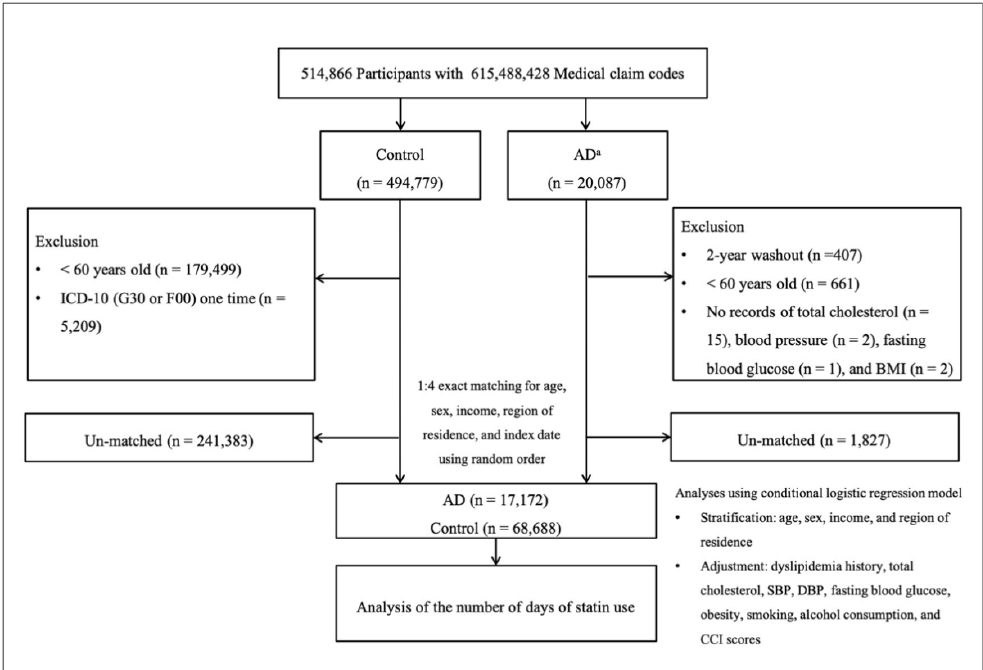
Figure 1. A schematic illustration of the participant selection process used in this study. Of the total 514,866 participants, 17172 AD patients were matched with 68688 control participants for age, gender, income, and region of residence. “a” indicates that AD patients were selected as the participants assigned G30 or F00 based on ICD-10 codes ≥ 2 times. AD–Alzheimer’s disease; BMI–body mass index; CCI–Charlson Comorbidity Index; DBP–diastolic blood pressure; SBP–systolic blood